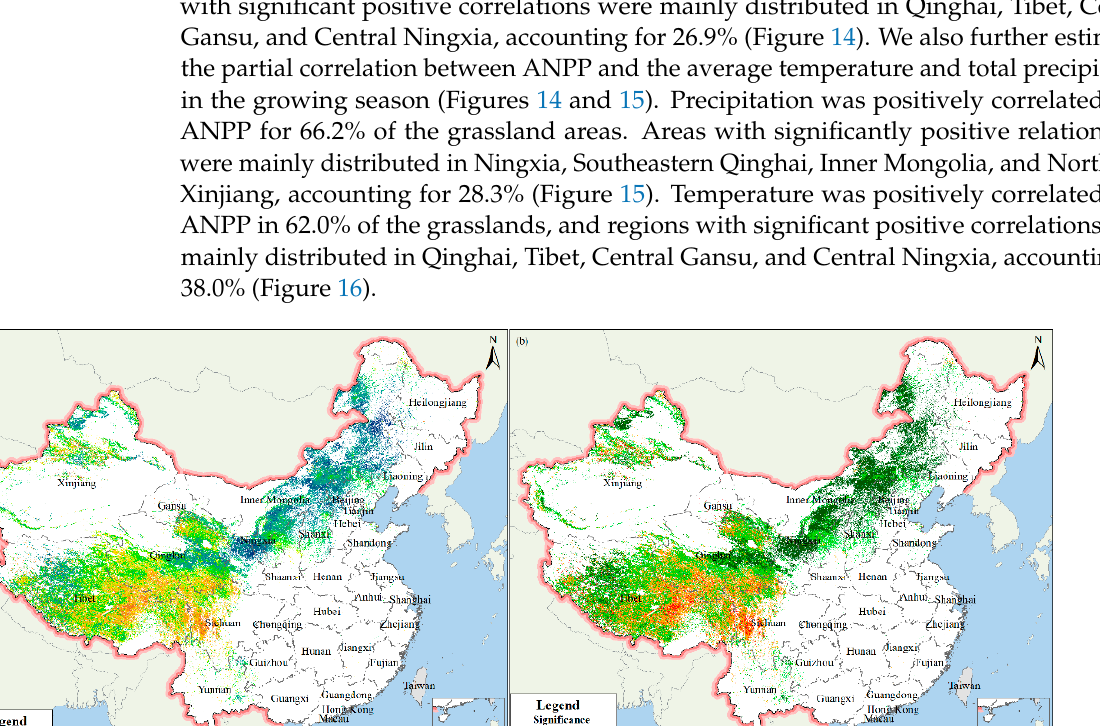
Figure 12. Spatial distribution of ( a ) multiple correlation coefficient between ANPP and the average temperature and total precipitation in the growing season and ( b ) the significance level.